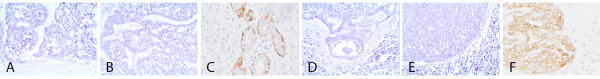
Basal-like phenotype: concordant case. ER–, c-erbB-2–, CK5/6+ (1A, 1B, 1C) in mammary neoplasia and PR–, c-erbB-2–, CK 14+ (2C, 2D, 2E) in the lymph node metastasis. 400x.